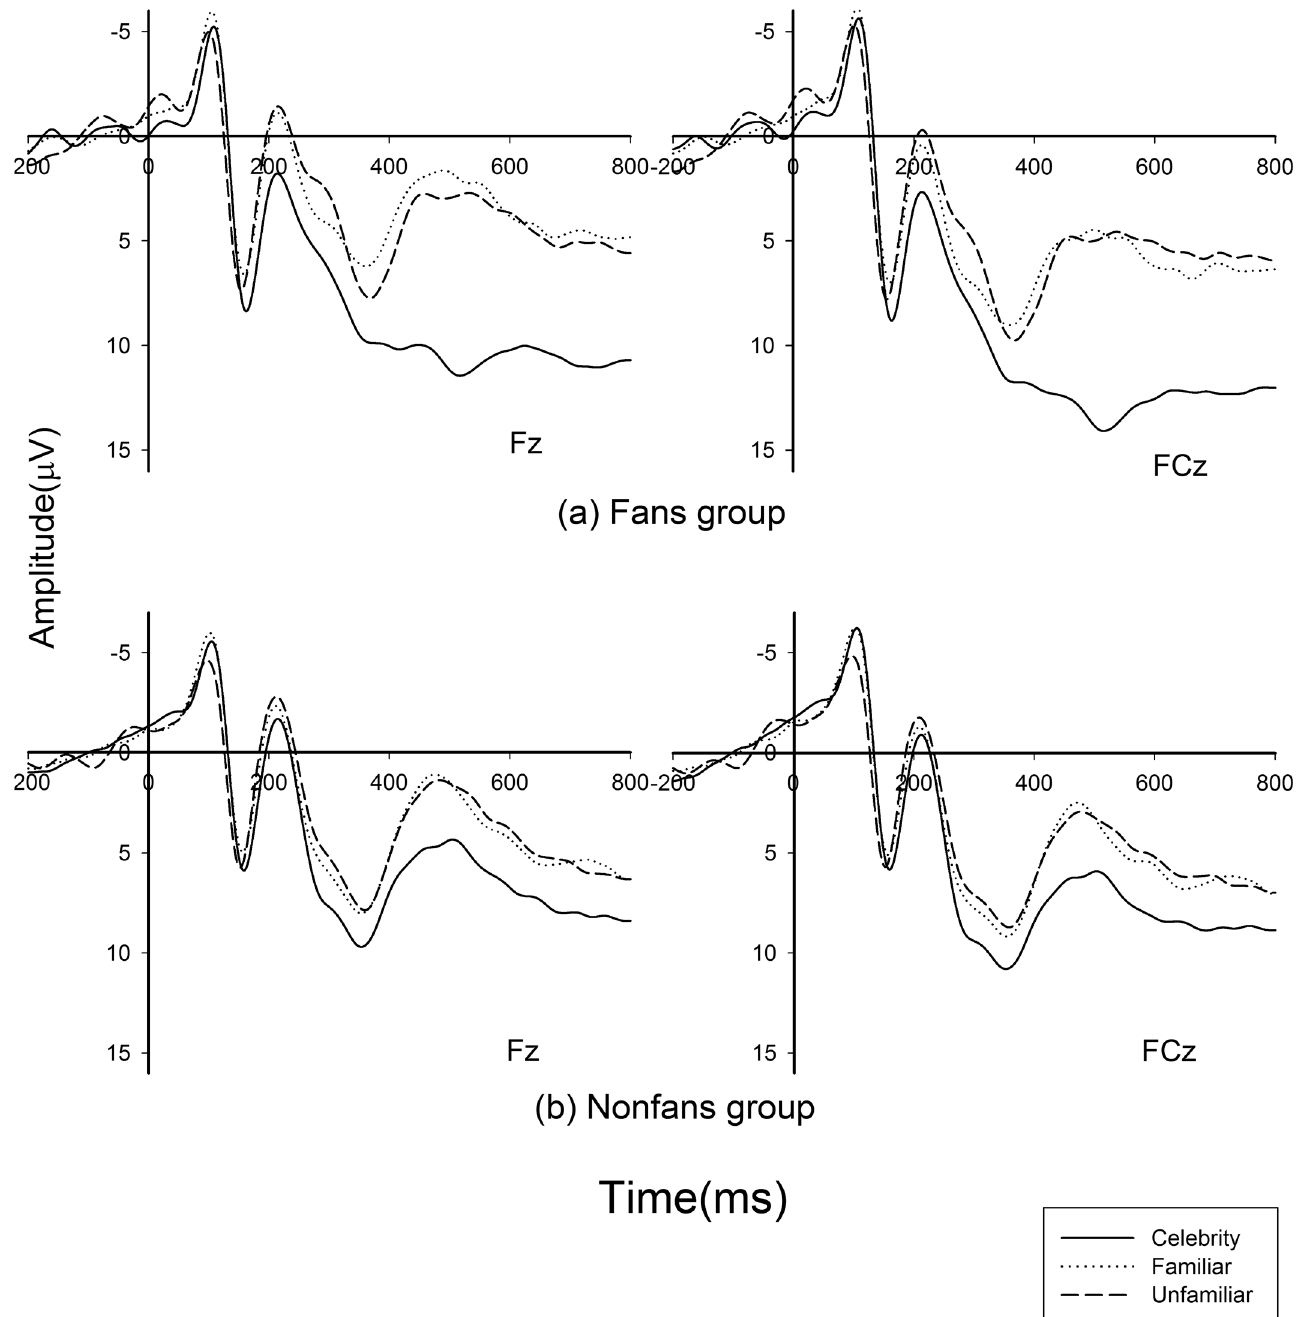
Fig 1. N2 results. Grand average ERP waveforms from channels Fz and FCz, which stand for the selected six electrodes as a function of the three conditions (celebrity, familiar person, and unfamiliar person) for fans (a) and non-fans (b)